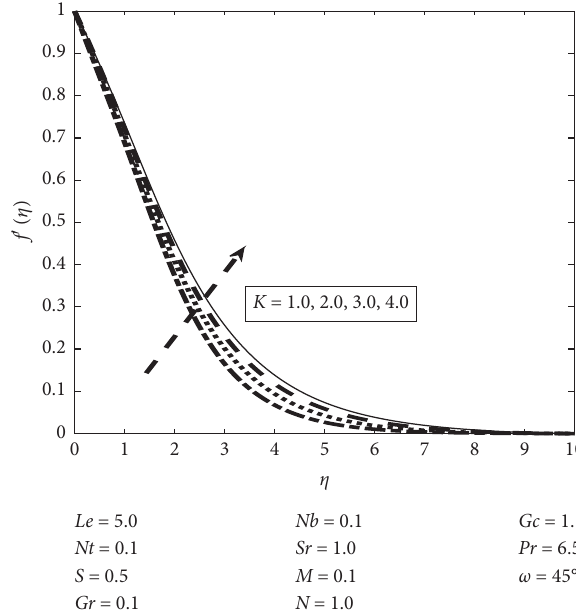
Figure 3: Velocity profile for several values of K .